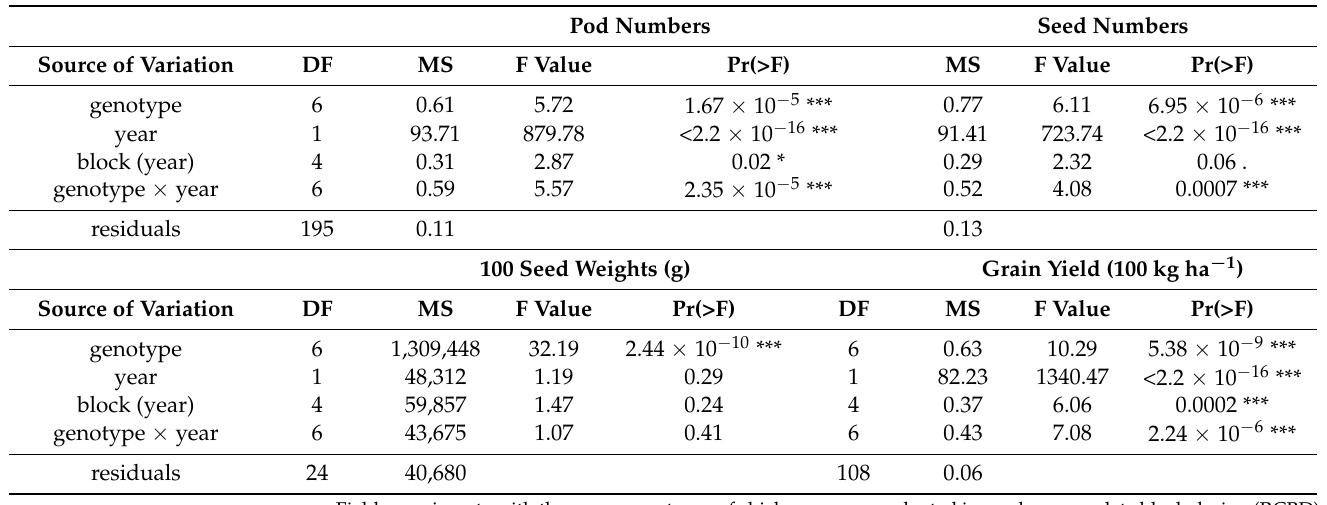
Table 2. Analyses of variance for the grain yield components of the seven chickpea genotypes grown under a low-P